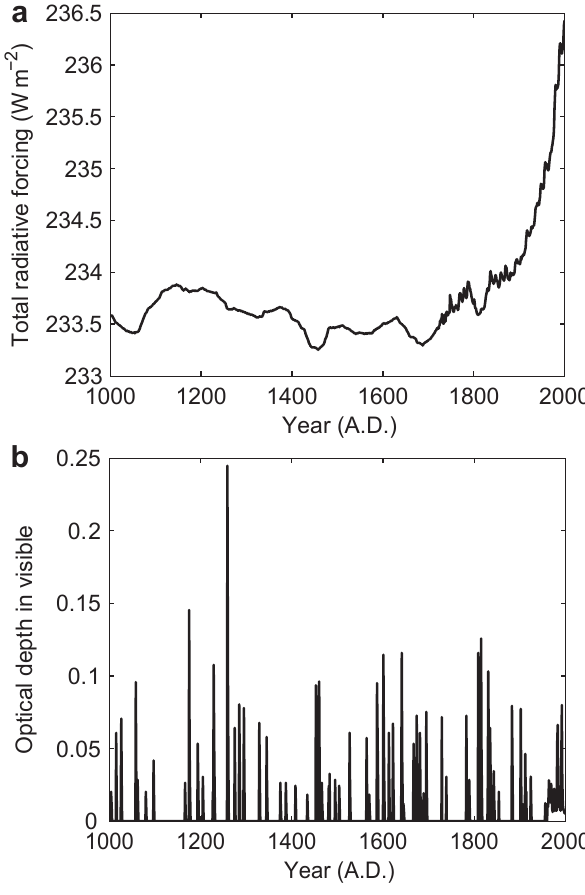
Fig. 1. Forcing from 1000 to 2000 A.D.: (a) the total radiative forc- ing due to solar irradiance and GHGs; (b) the optical depth changes in the visible band due to volcanic aerosols. The radiative forcing is estimated according to IPCC (2001, Table 6.2) assuming an albedo of